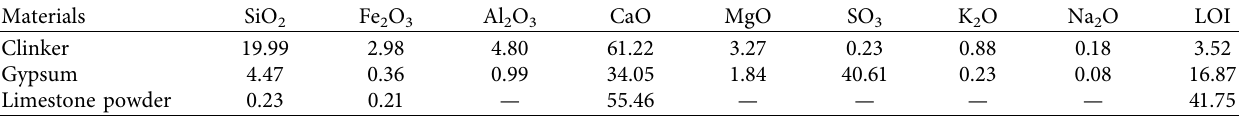
Table 1: Chemical components of the clinker, gypsum, and limestone powder (wt%). Materials